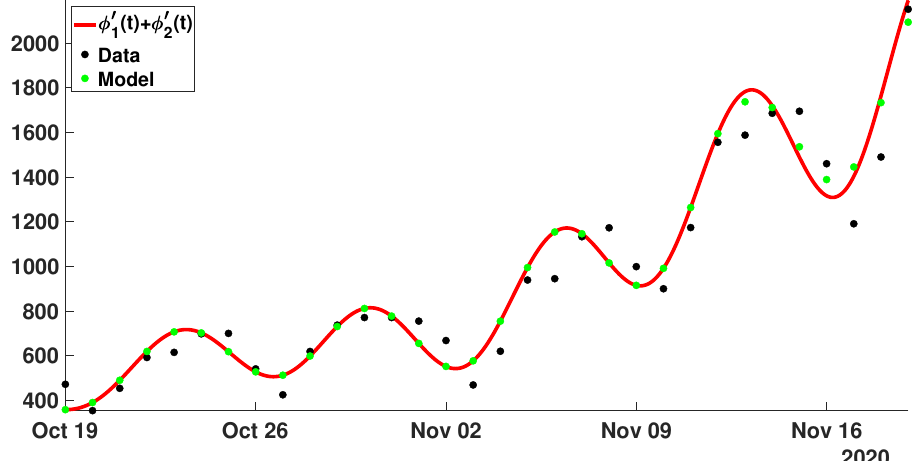
Figure 19. In this figure, we plot the daily number of reported cases data between 19 October and 19 November 2020 (black dots). The red curve corresponds to φ (cid:48) spond (34) and (35) whenever R 0 ( d ) comes from the average distribution (i.e., the red curve in Figure 15). We observe a very good match between the green dots and the red curve (the phenomeno- logical